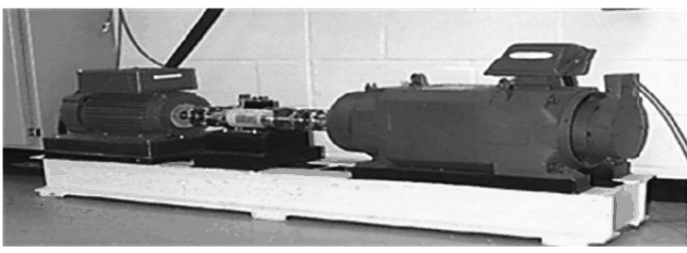
Fig. 4. Experimental